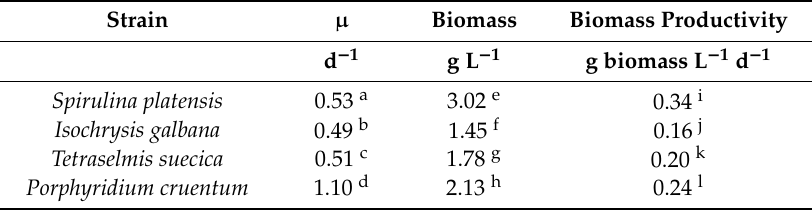
Table 1. Growth parameters. Values obtained in bath cultivation for 9 days’ growth. Strain µ